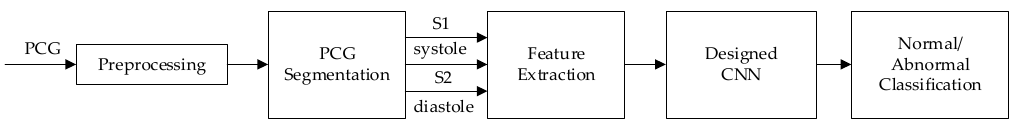
Figure 1. Block diagram of the proposed method. First, the phonocardiogram (PCG) is preprocessed and segmented. After that, the four states of each PCG recording are used to extract multiple features. Finally, the extracted features are fed into the designed convolutional neural network (CNN) model to classify normal and abnormal heart sounds.